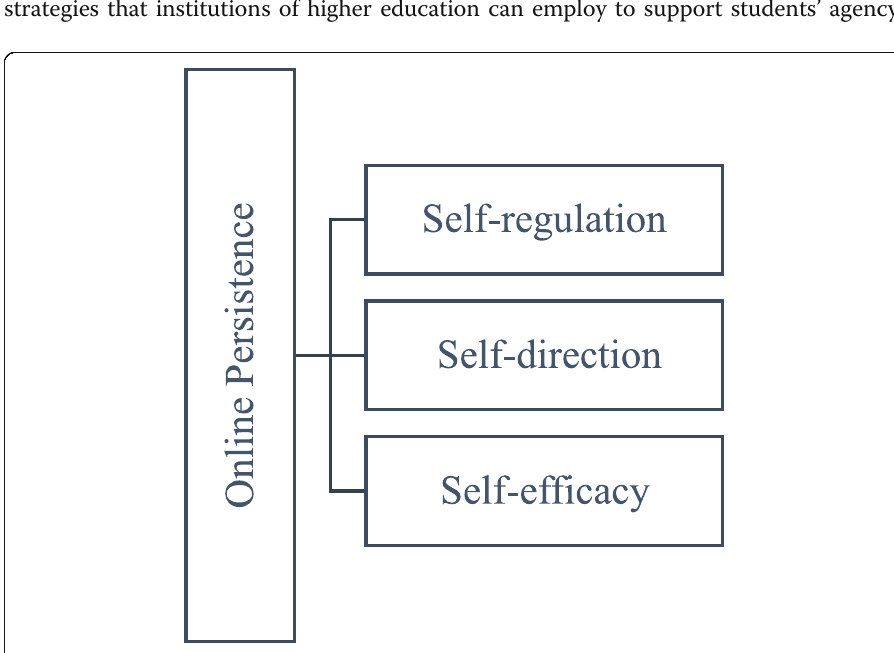
Fig. 1 Elements of Human Agency and the Persistence of Online